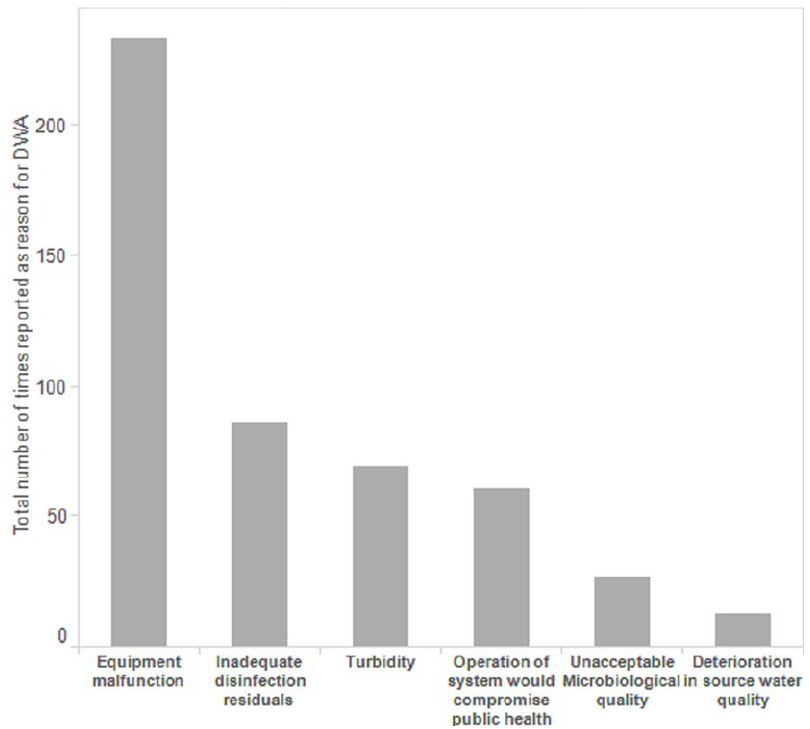
Figure 1. Reasons for DWAs in First Nations drinking water systems in Ontario, 2004–2013.